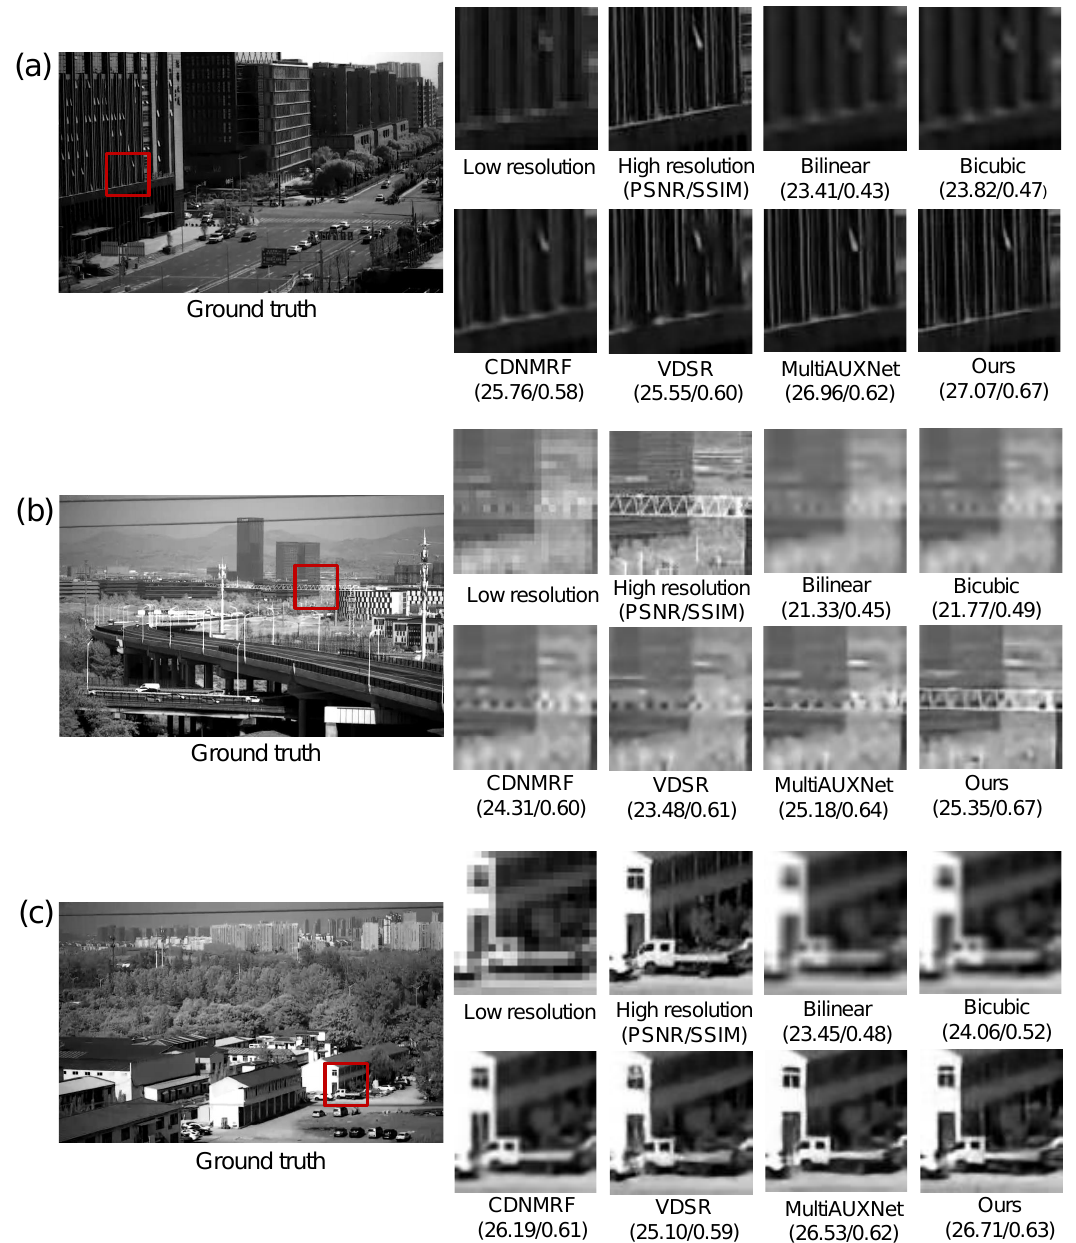
Figure 8. Comparison of the super-resolution results with different networks. ( a – c ) Different test